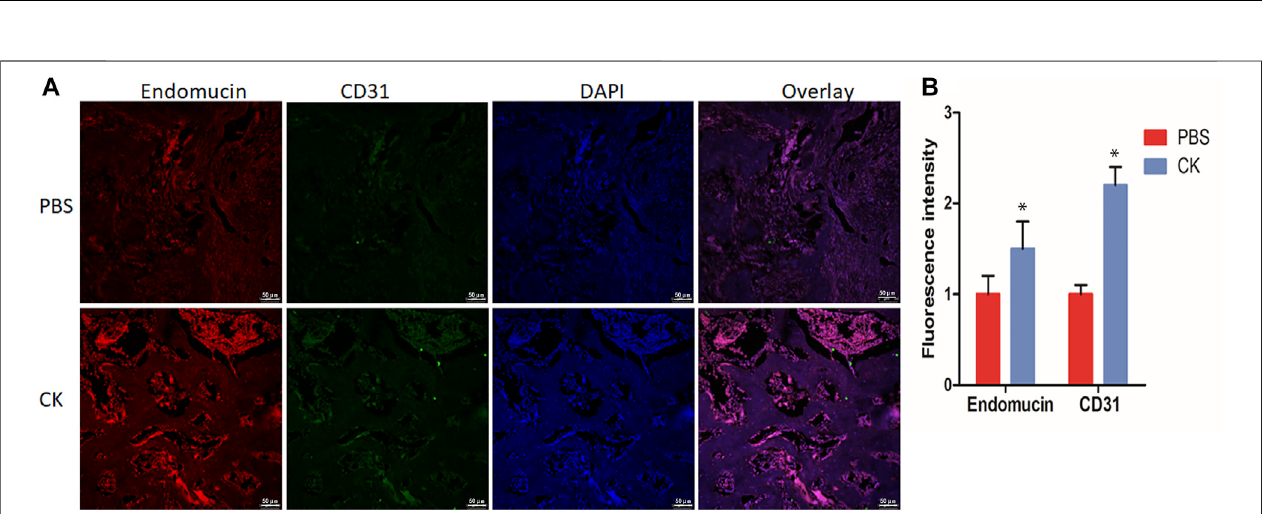
Frontiers in Pharmacology |